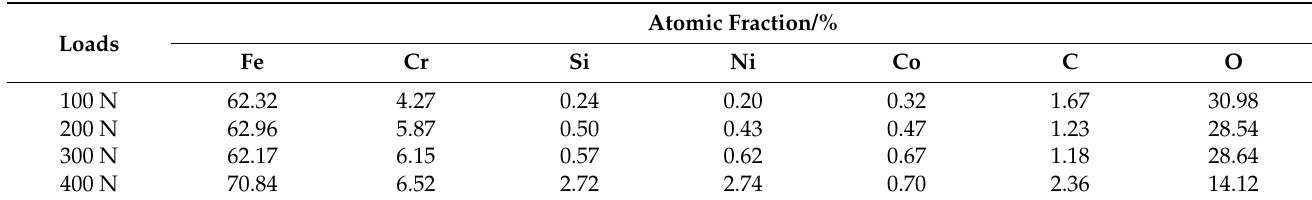
Table 6. EDS analysis results of worn surfaces of FeCrSiNiCoC coatings at various loads.